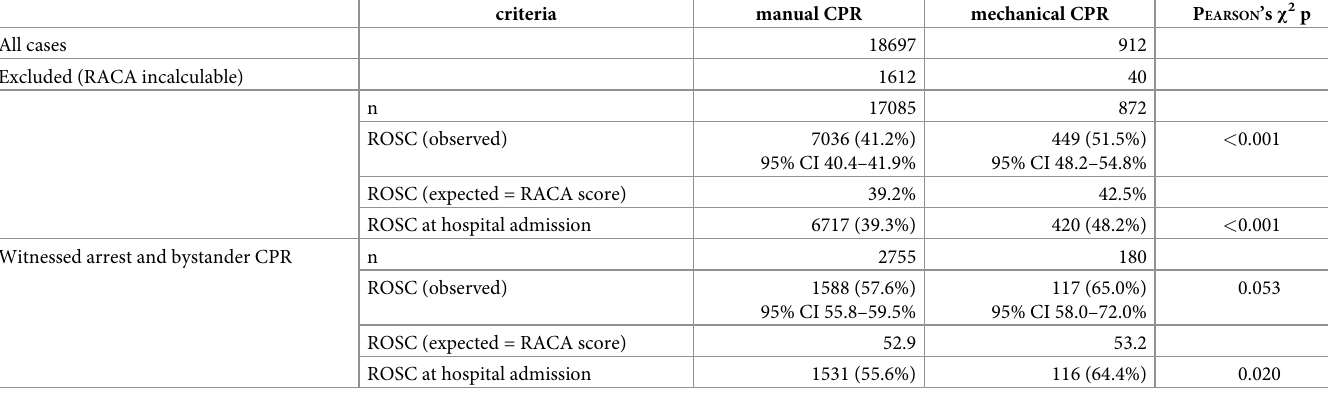
Table 3. Comparison of observed and predicted return of spontaneous circulation